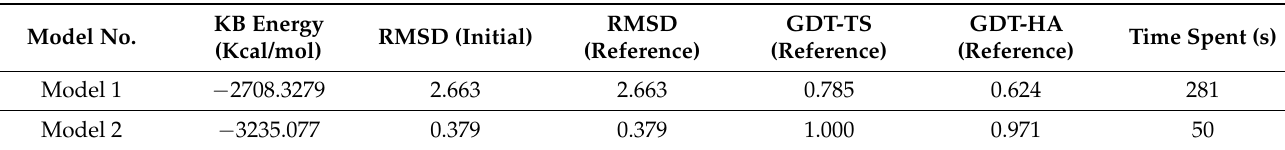
Table 3. Minimized energy and other parameters from KoBaMIN.